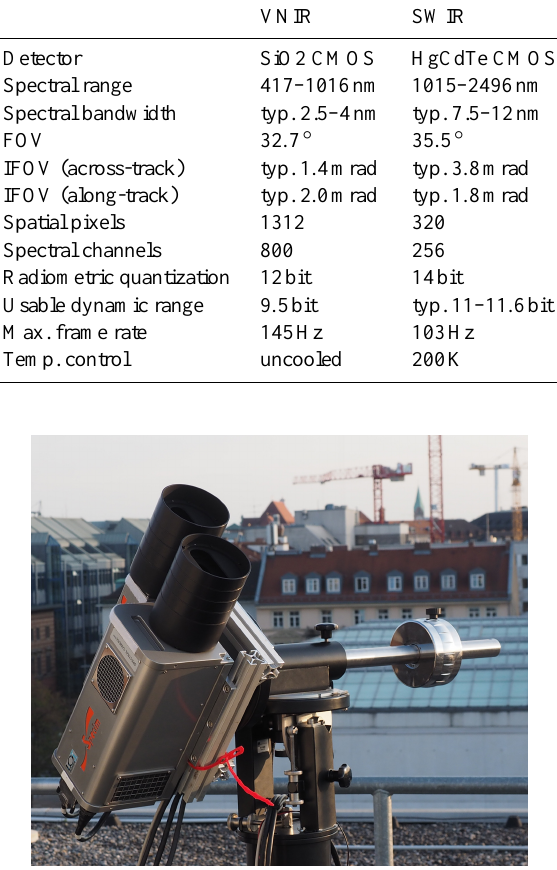
Figure 1. specMACS VNIR and SWIR sensors on the scanning mount. The stray light protection is prominently visible in front of the